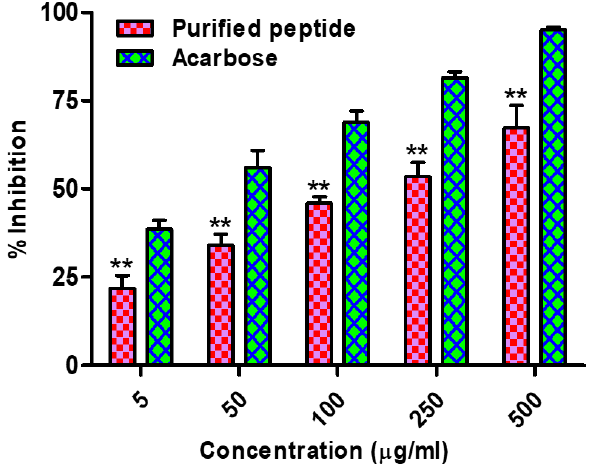
Figure 14. Inhibitory effects of chickpea peptide against α amylase. ** significantly different from each other ( p < 0.05).